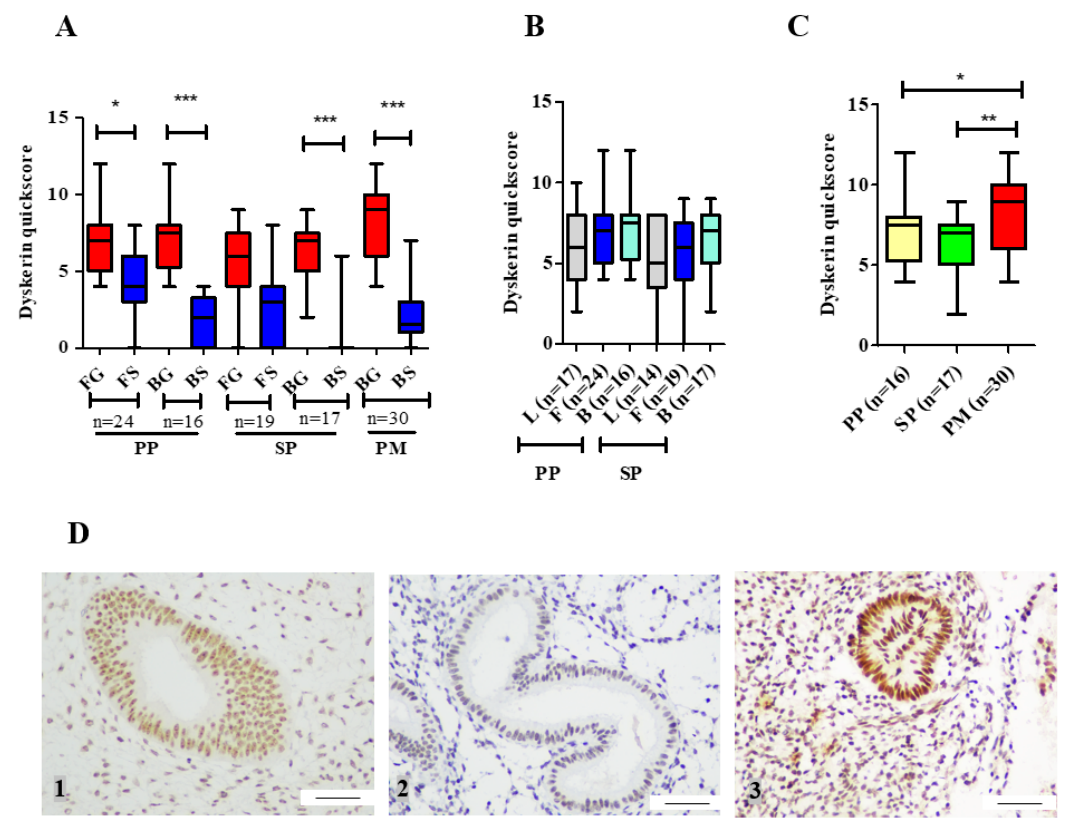
Figure 4. Dyskerin immunostaining in human endometrial tissue samples. ( A ) The difference in dyskerin immunoscores between epithelial and stromal compartments in functionalis and basalis layers of proliferative phase (PP), secretory phase (SP), and postmenopausal (PM) endometrium. Functionalis gland (FG), Functionalis stroma (FS), basalis gland (BG), and basalis stroma (BS). ( B ) Dyskerin immunoscores in the epithelium of the three endometrial layers: Luminal (L), functionalis (F) and basalis (B) of premenopausal PP and SP endometrium. ( C ) Dyskerin quickscores in basalis glands of PP ( n = 16), SP ( n = 17) and PM endometria ( n = 30). ( D ) Representative microphotographs illustrating dyskerin immunostaining in the following endometrial samples (1) healthy proliferative phase (PP), (2) Secretory phase (SP) and (3) Healthy postmenopausal (PM) endometrium. Positive staining appears brown. Magnification 400×. Scale bar 50 μ m. (BS). * p < 0.05, ** p < 0.01, *** p < 0.001.